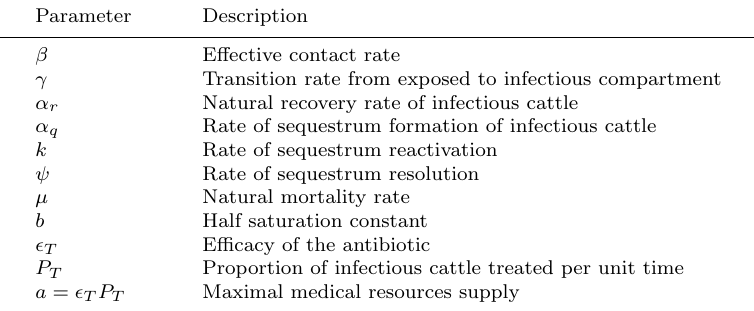
Table 1. Description of parameters.